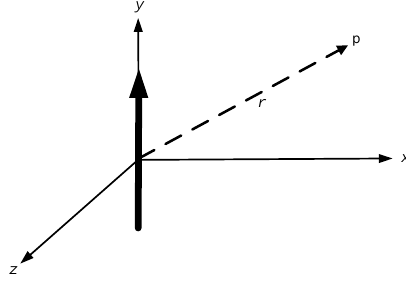
Figure 2. Linear radiation source.